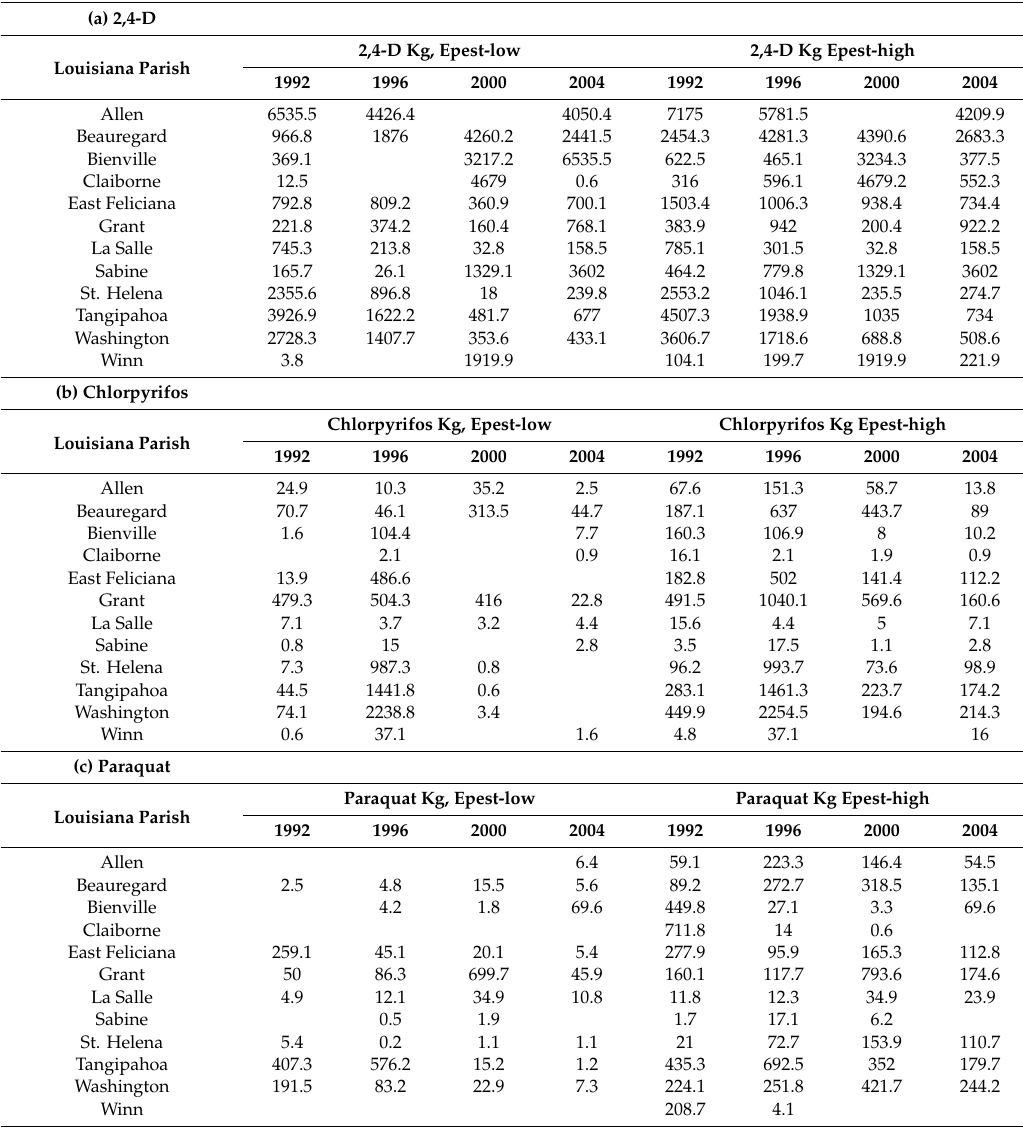
Table 4. USGS-estimated annual agricultural pesticide use for arbor–pastoral parishes (counties) in Louisiana, 1992–2004, from https: // pubs.usgs.gov / ds / 752 / For parish locations and relation to vegetation, see https: // geology.com / county-map /